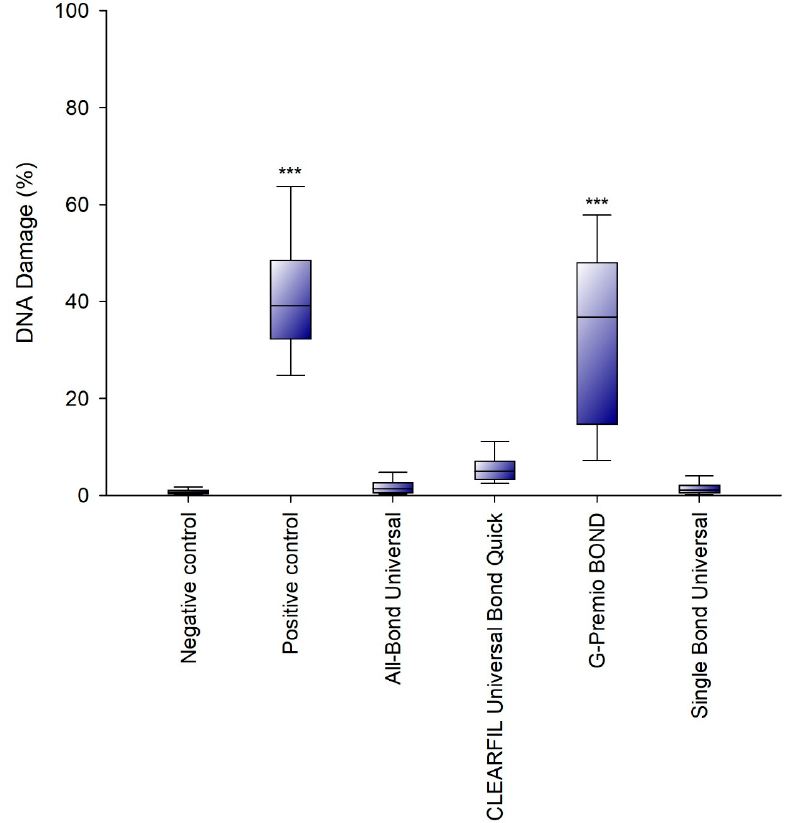
Figure 2. Genotoxicity of the investigated adhesives. Analysis was performed using an alkaline version of the comet assay after 24 h incubation of cells with the tested compounds. Cells suspended in 10% DMSO constituted a positive control. Cells suspended in 1 mL of complete culture medium constituted a negative control. The differences were statistically significant on the graphs as follows: *** p < 0.001 versus negative control. 3.3. Apoptosis Detection by FITC Annexin V/PI Double Staining of the Universal Dental Adhesives After treatment with staurosporine, a significant number of SC cells underwent apoptosis in comparison to the control cells only incubated with the complete cell culture medium. After a 24 h incubation, G-Premio Bond significantly induced apoptosis (approx- imately 39% of cells were at the early and late stages of apoptosis). The other UDA did not significantly induce apoptosis in the SC cell line tested. Additionally, none of the tested compounds evoked a significant increase in the level of necrotic SC cells (Figure 3).